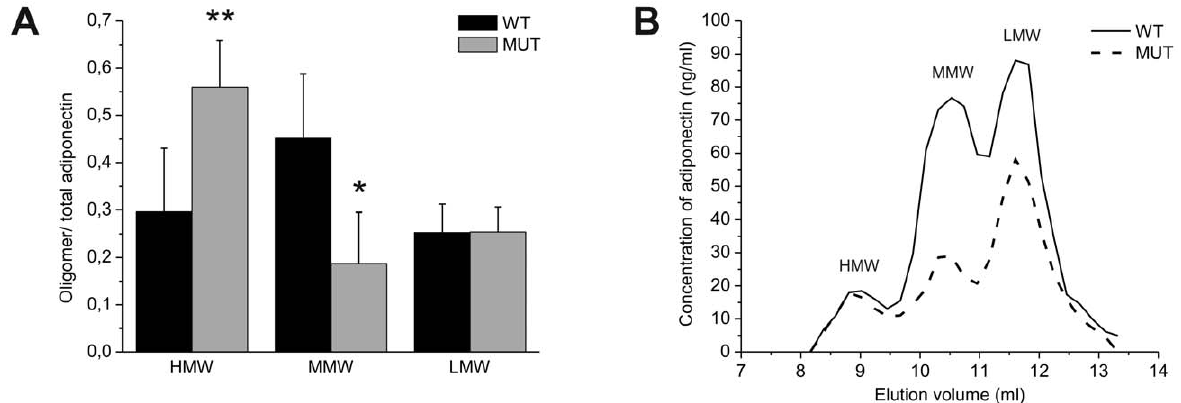
Figure 4. The distribution of adiponectin oligomers is altered in the serum of LH mutant mice. (A) The ratio of HMW/total adiponectin was significantly increased and MMW/total decreased in serum of 2 months old male mice, even though the total amount of adiponectin was lowered as seen in the elution profile of adiponectin (B). The oligomeric forms were separated with gel filtration chromatography and quantified either from adiponectin immunoblots (A) or by ELISA (B). The level of oligomeric forms (A) was calculated as a proportion of total adiponectin. The values represent the average 6 SD of the experiments. P values were calculated using unpaired homoscedastic student t-tests with two-tailed distribution.* p , 0.05, ** p , 0.01, *** p , 0.001.